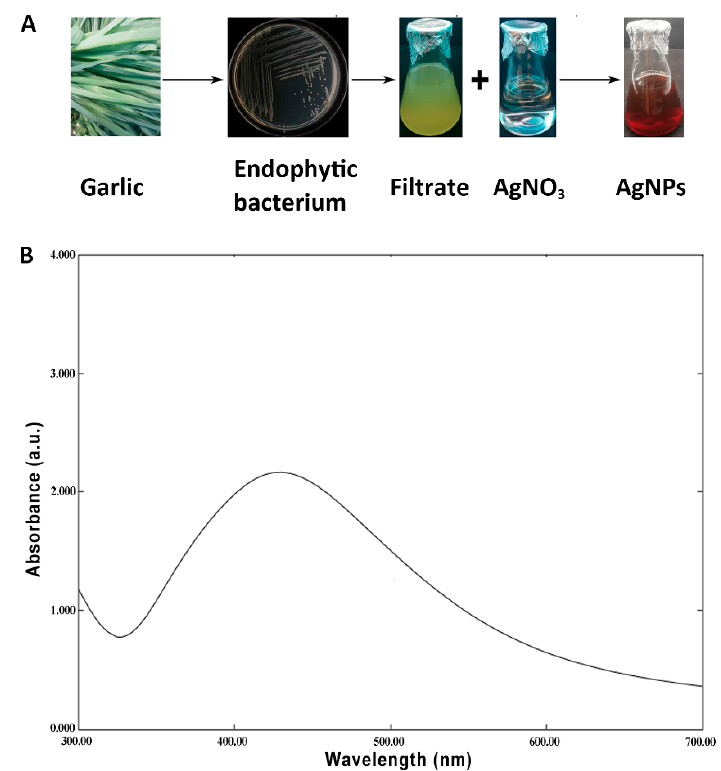
Figure 1. Confirmation of biosynthesized silver nanoparticles (AgNPs). ( A ) Color changes from light yellow to dark brown following the incubation of AgNO 3 with the culture filtrates of the endophytic bacteria Pseudomonas poae strain CO isolated from garlic. ( B ) UV–Vis spectrum of AgNPs that were synthesized by the endophytic bacteria P. poae strain CO.